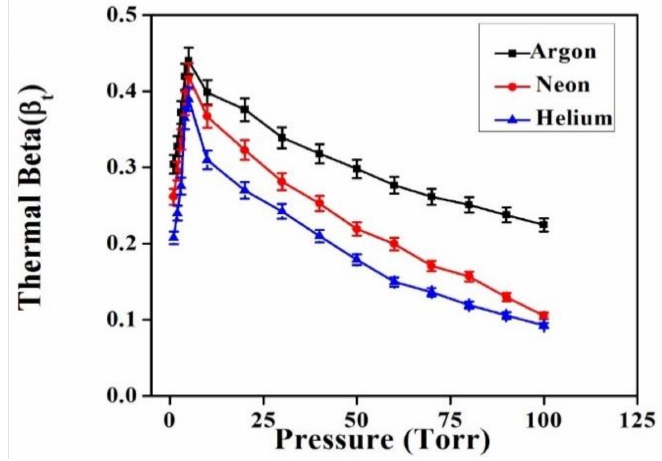
Figure 6. The variation in thermal beta of laser-induced Mg alloy plasma at various pressures under Ar, Ne, and He environments at ns laser irradiance of 2 GW/cm 2 . Table 2. Evaluated T exc , n e , and β t values for laser-irradiated Mg plasma at various Ar pressures in the presence and absence of TMF.